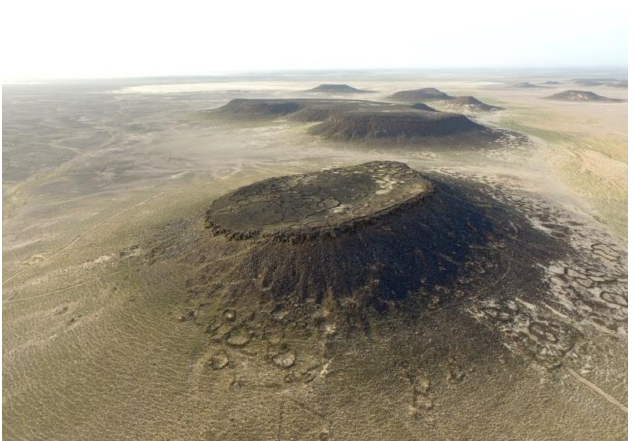
Figure 3. Oblique view of Wadi al-Qattafi with anthropogenic features visible. Looking north, M4 in the